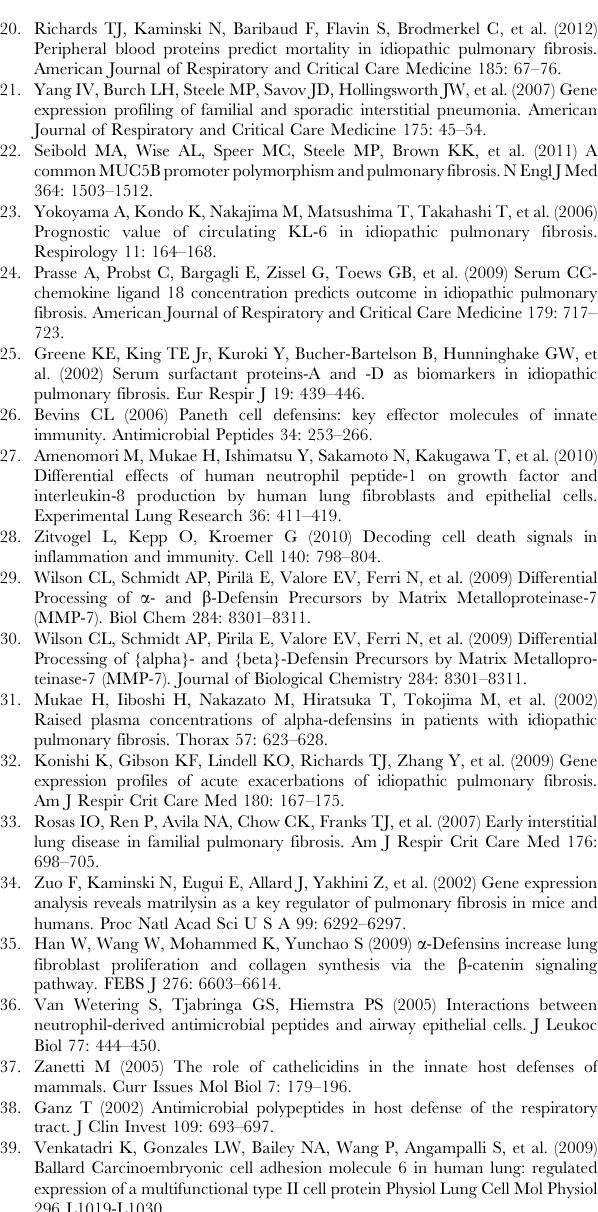
Table S5 Canonical pathway analysis using Ingenuity Pathway Analysis TM tool to identify associated net- works. Network functions with their respective P values and the number of differentially-expressed genes identified are presented. Table S6 Differentially-expressed genes between con- trols and mild IPF (D L CO . 65%) using SAM at FDR of , 1%. Agilent probe identifier, RefSeq number, and Entrez geneID number are presented. Fold change is log 2. FDR is false discover rate (%). Table S7 Differentially-expressed genes between con- trols and severe IPF (D L CO , 35%) using SAM at FDR of , 1%. Agilent probe identifier, RefSeq number, and Entrez